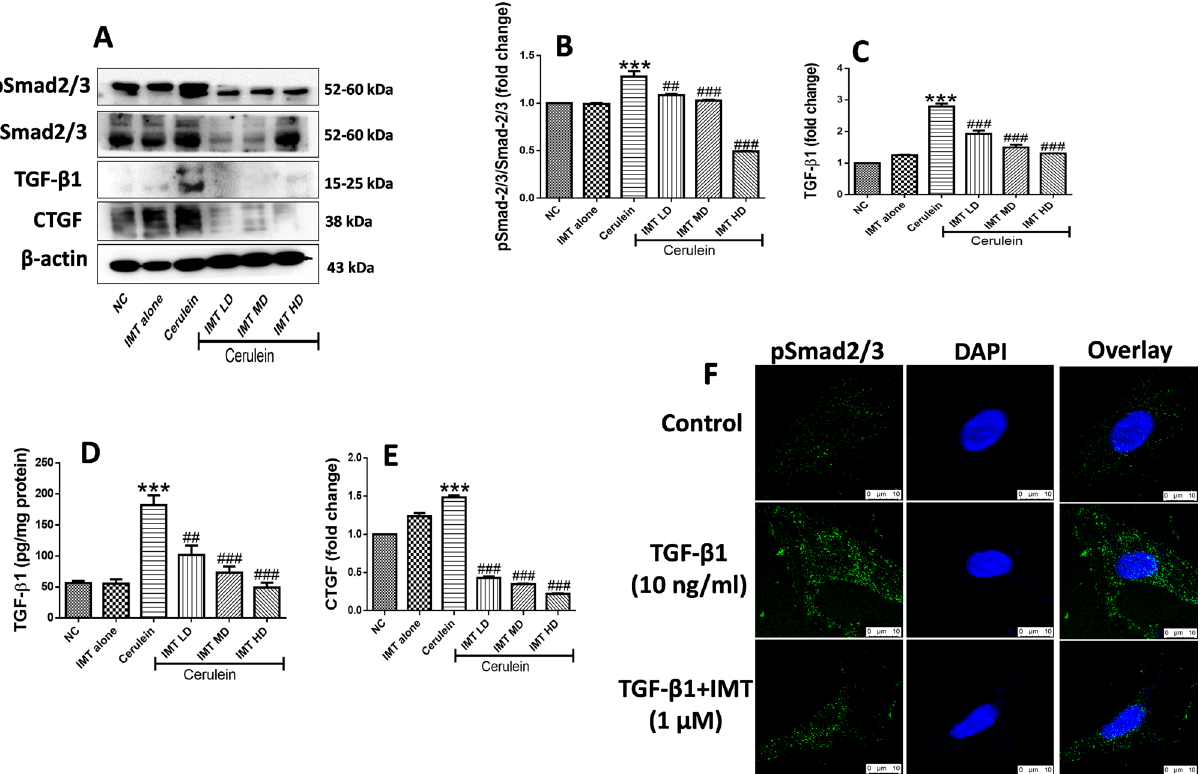
Figure 7. Effect of IMT on TGF-β1/Smad signaling pathway. ( A – D ) Western blot and corresponding densitometric analysis of protein expression of phosphorylated and total Smad2/3, TGF-β1 and CTGF in pancreatic tissue, ( E ) Pancreatic TGF-β1 levels studied by ELISA. ( F ) IF staining for phosphorylated Smad2/3 in TGF-β1-induced PSCs. β-actin was used as loading control. All values are represented as mean ± SEM (n = 3). Statistical significance was established using one-way ANOVA followed by Tukey’s multiple comparisons test where ***P < 0.001 vs Normal control, ## P < 0.01, ### P < 0.001 vs Cerulein. Full-length blots are presented in Supplementary Fig.